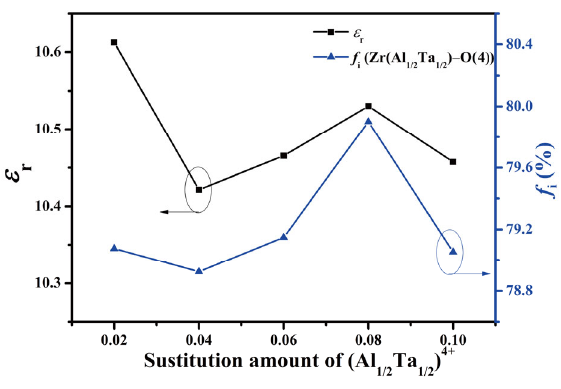
Fig. 11 ɛ r and the Zr(AlTa)–O(4) bond ionicity of CZMAT ceramics as a function of